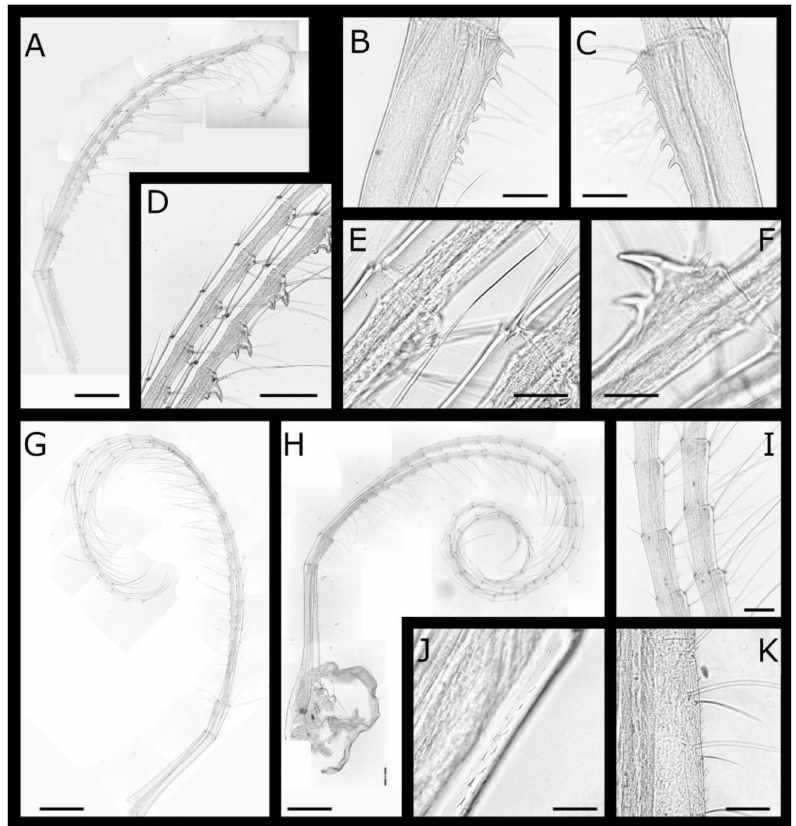
Figure 20. Pectinoacasta cancellorum (Hiro, 1931) cirri IV–VI (WAM C55340): ( A ) left cirrus IV; ( B ) basis of left cirrus IV protopod; ( C ) same of right cirrus IV; ( D ) medial segments of cirrus IV; ( E ) small spinules on medial segments of cirrus IV posterior ramus; ( F ) erect spines on medial segments of right cirrus IV anterior ramus; ( G ) right cirrus V; ( H ) left cirrus VI with penis; ( I ) medial segments of left cirrus VI; ( J , K ) close up of posterior and anterior margin of cirrus VI protopod basal segment. Scale Bars: A, G, H = 500 µ m; B, C, I = 100 µ m; D = 200 µ m; E, F, J, K = 50 µ